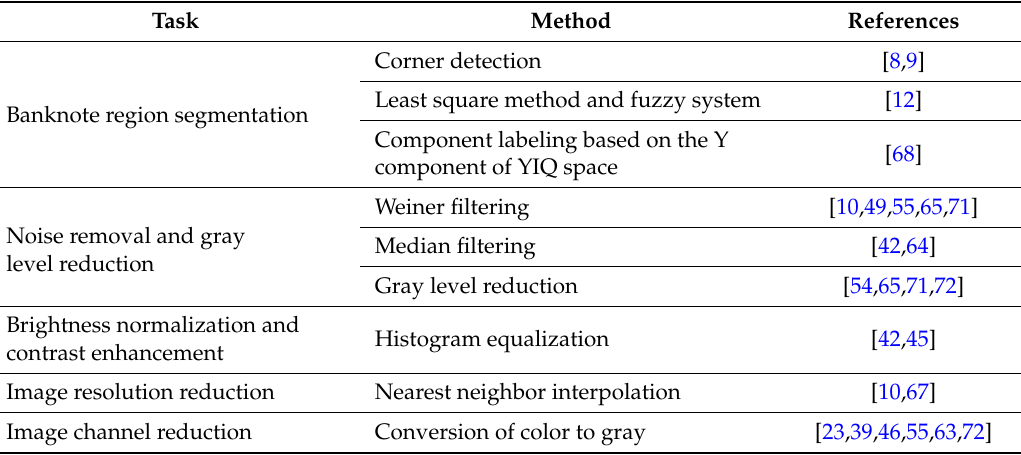
Table 2. Methods for preprocessing in the banknote recognition process flow.